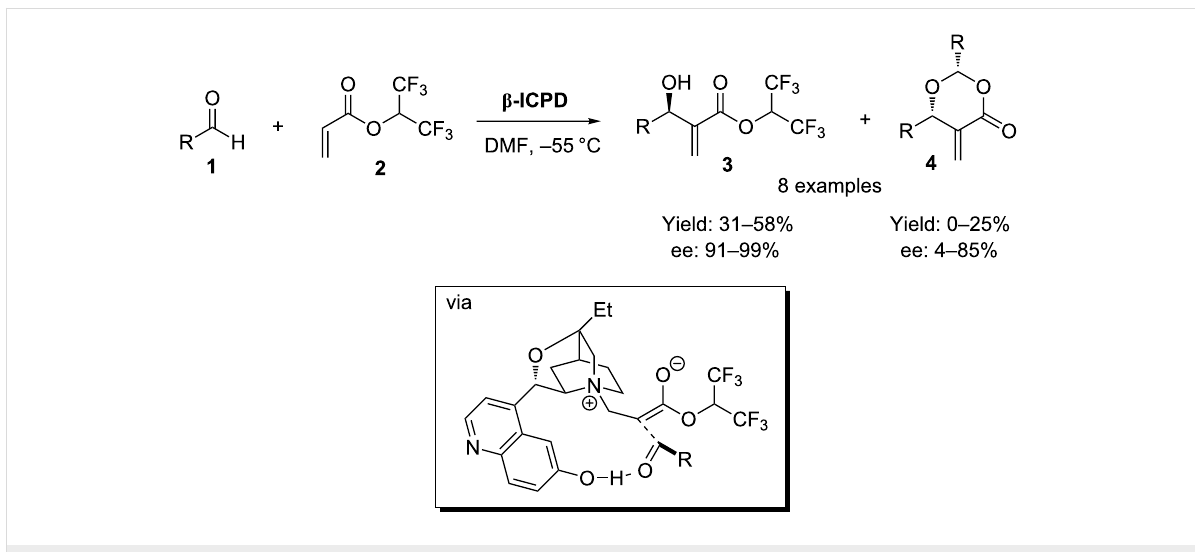
Scheme 1: The original 6’-OH cinchona alkaloid organocatalytic MBH process, showing how the free 6’-OH is essential for coordination to the substrate.